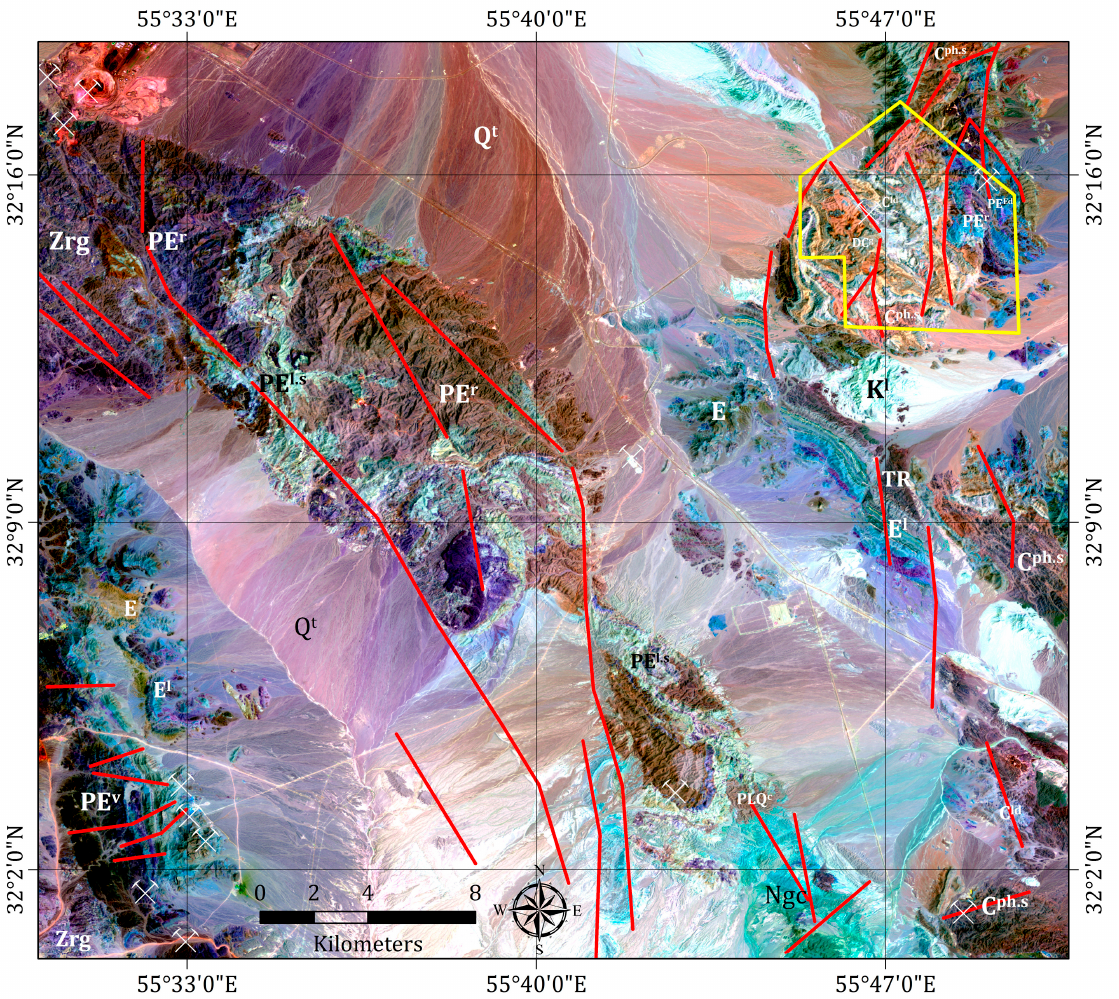
Figure 4. Regional view of lithological units and alteration zones in the study region. RGB false color composite of bands 2, 8 and 12 for Sentinel-2. Yellow polygon demarcates WV-3 imagery.